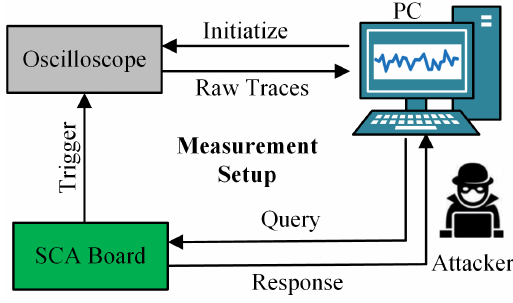
Figure 2. Overview of the SCA trace acquisition